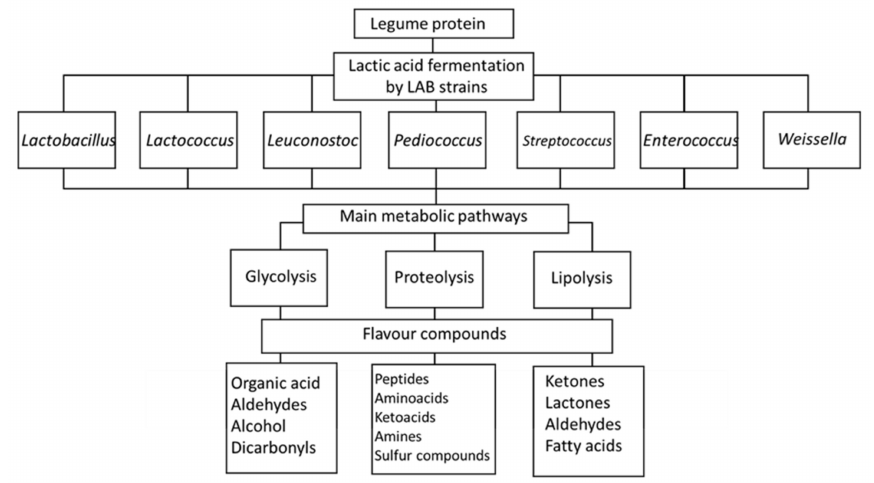
Figure 2. Schematic of the main pathway in lactic acid fermentation leading to the production of aromatic